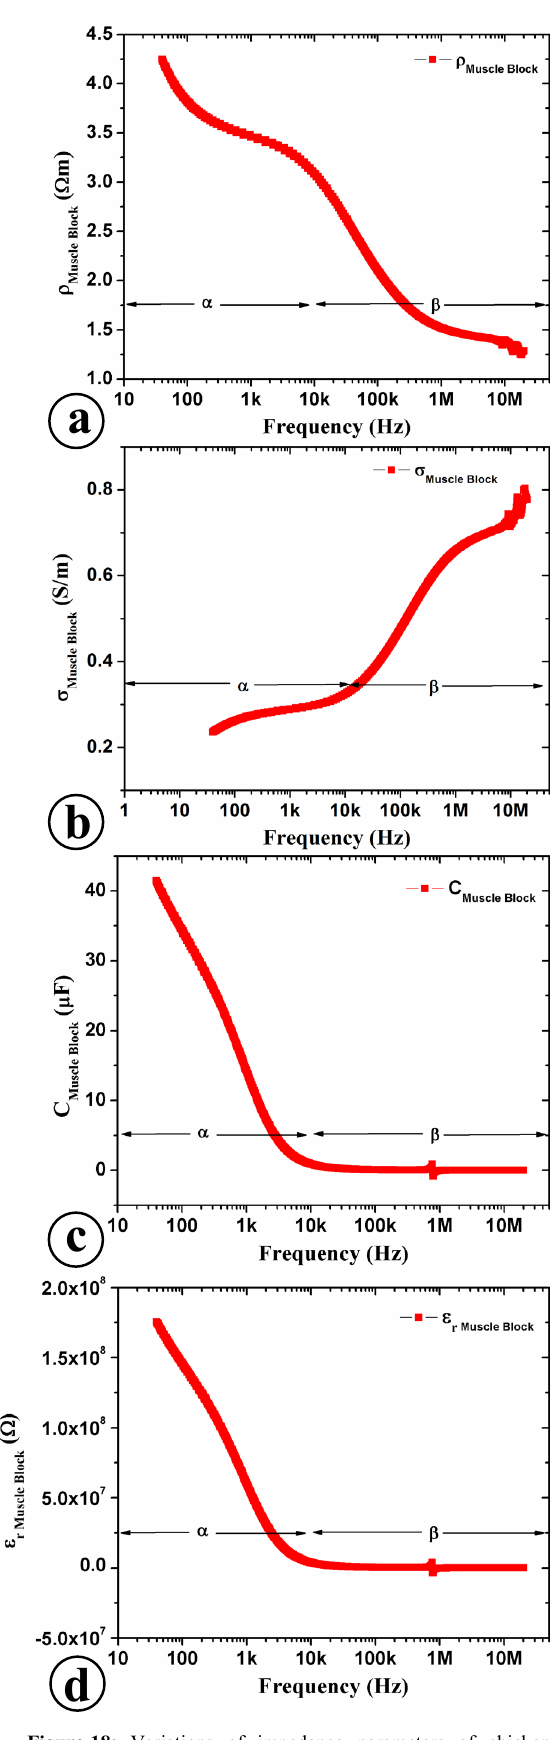
Figure-17: Variations of impedance parameters of chicken muscle tissue paste over frequency: (a) Z Muscle Paste , (b) θ Muscle Paste , (c) R Muscle Paste , (d) X Muscle Paste .